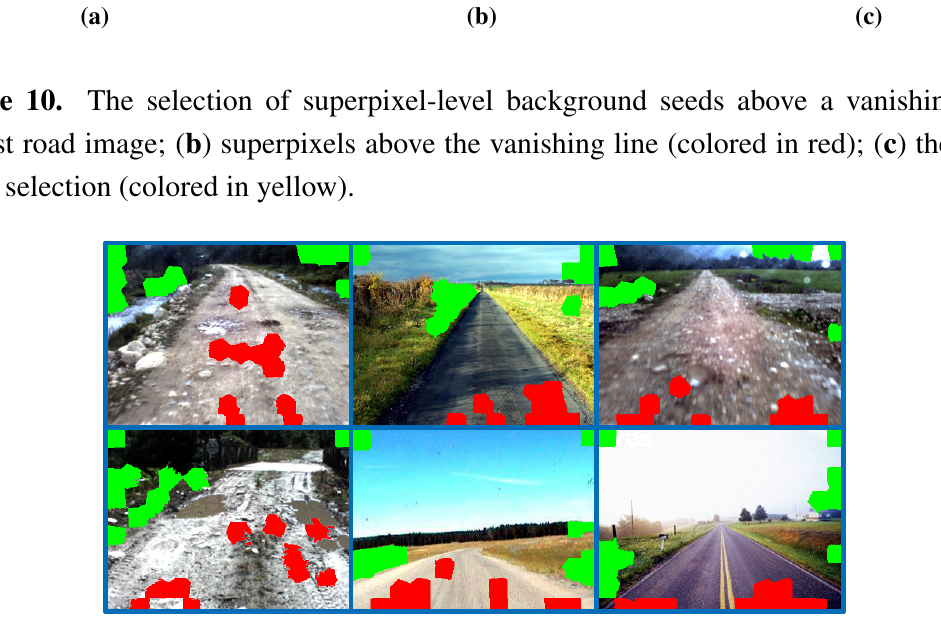
Figure 11. The results of superpixel-level seed selection (road seeds are colored in red; background seeds are colored in